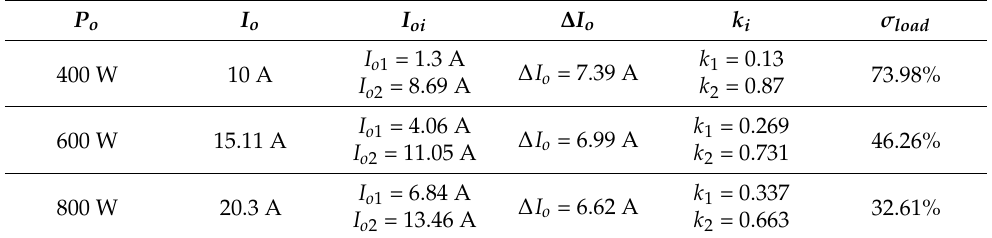
Table 7. Data comparison of different output power without current sharing control when c =